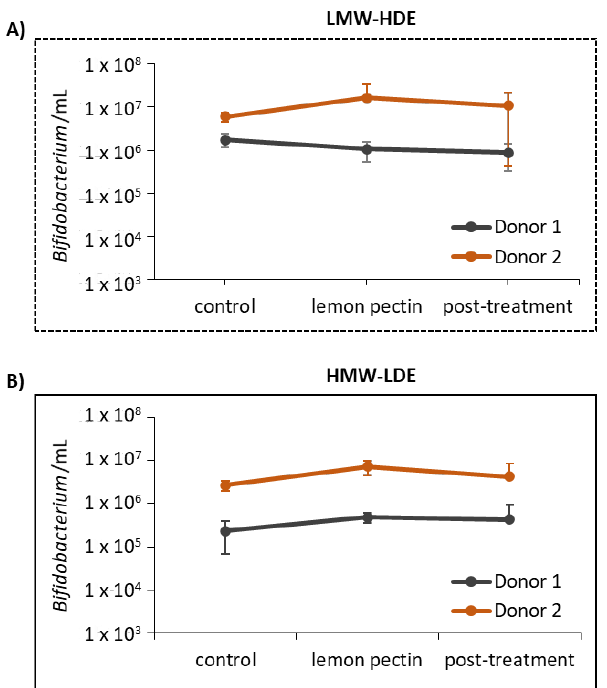
Figure 5. Bifidobacterium levels as determined by qPCR analysis. ( A ) LMW-HDE lemon pectin; ( B ) HMW-LDE lemon pectin.